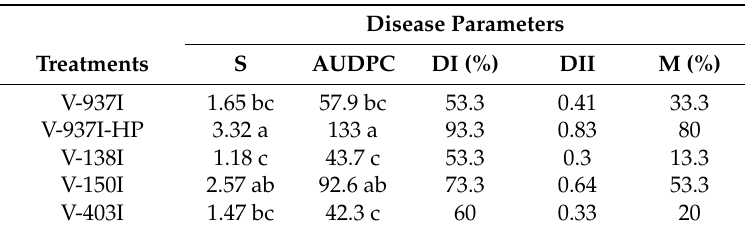
Table 1. Di ff erential virulence in olive (cv. Picual) plants displayed by the Verticillium dahliae defoliating isolates used in this